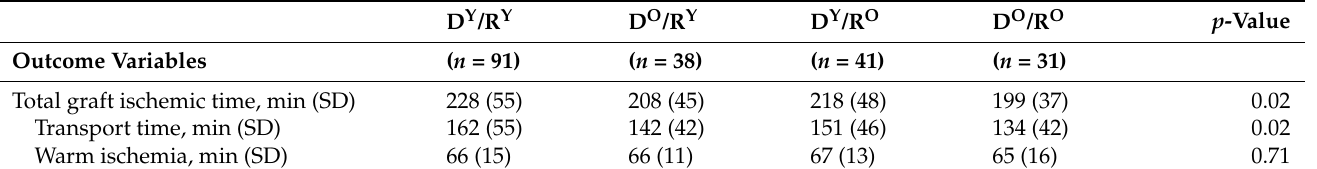
Table 3. Operative outcome.